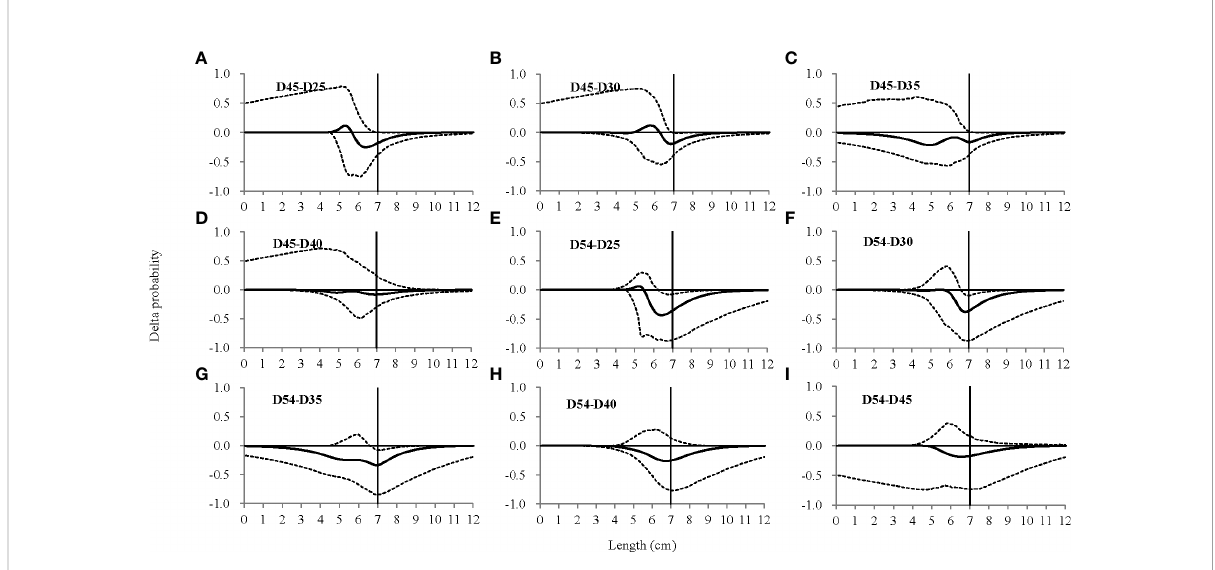
FIGURE 6 Delta selectivity from the comparison among six codends — the D25, D30, D35, D40, D45, and D54 codend. The solid black curves represent the delta selectivity for each comparison, and the stippled curves represent the 95% con fi dence intervals. The vertical lines represent the minimum conservation reference size (7.0 cm) of the target shrimp. (A – I) represents the D45-D25, D45-D30, D45-D35, D45-D40, D54-D25, D54-D30, D54-D35, D54-D40, and D54-D45 comparison,